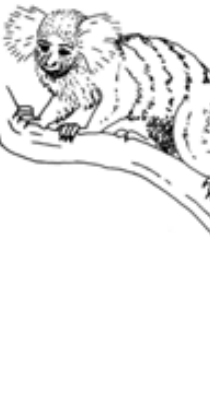
Figure for Box 1 Figure for Box 2 Figure for Box 3